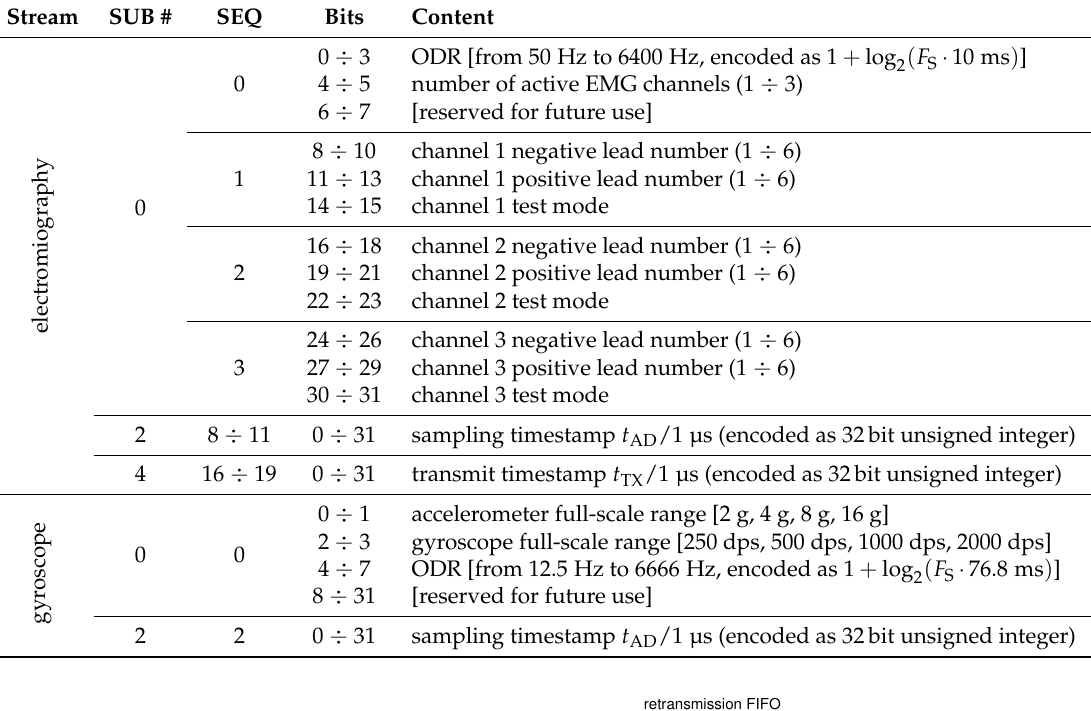
Table 2. Subchannel definitions. Metadata is optionally added to packets to describe acquisition parameters such as data rate, number of active channels, full-scale ranges, and timing information. The type and format of metadata depends on which subchannel it is transmitted on. Subchannels are identified by the sequence number of the packet containing them. Four consecutive packets are needed to convey a single subchannel for the EMG stream as only extra 8bits are available on the data packets. For the GYR stream this splitting is not needed and a whole subchannel is included in a single data packet. Care has been taken in choosing subchannel indices, as of course configuration metadata is needed to interpret the main data and must come with the first packet, while transmission timestamps (which refer to the time packet #0 was transmitted) are available after the fact and their inclusion in the stream must be postponed to account for queuing delays.